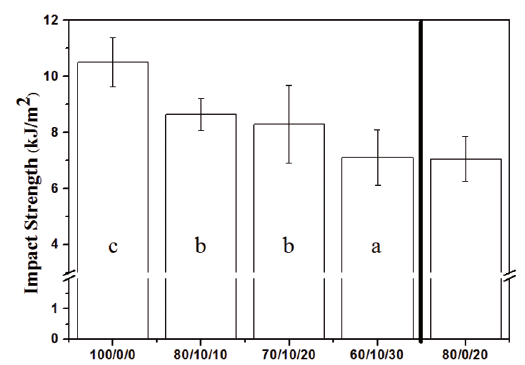
Figure 8: Impact strength of the